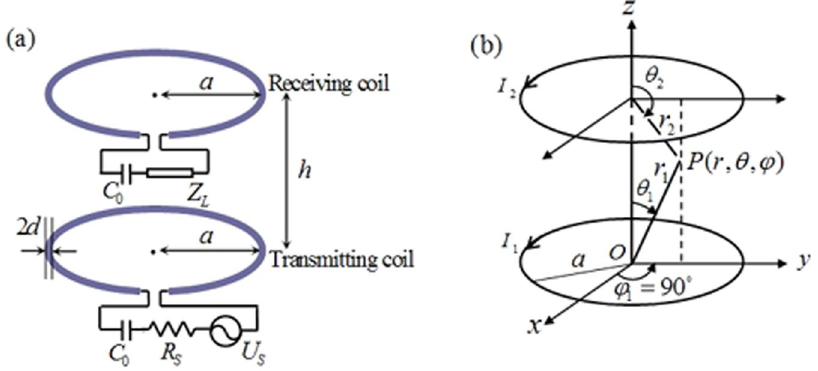
Figure 1. Theoretical model of WPT system. ( a ) Equivalent circuit model. ( b ) Equivalent magnetic dipole